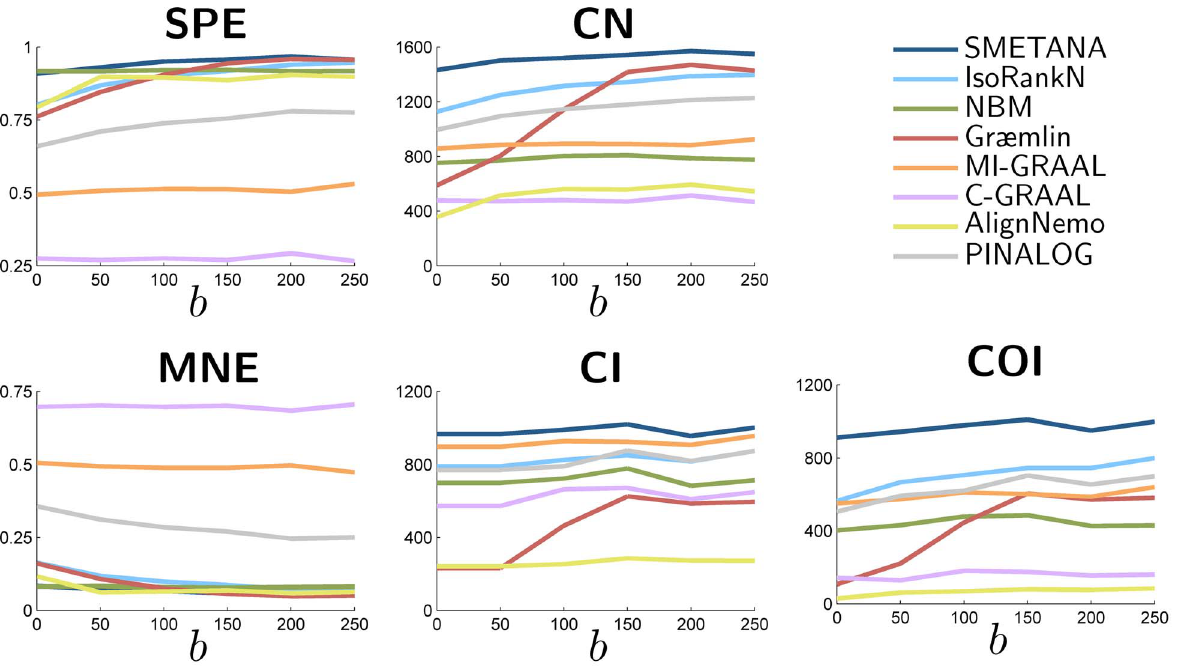
Figure 4. Effects of node similarity on the performance of different network alignment algorithms. The alignment performance has been estimated at several different levels of separation between the similarity score distribution for orthologous node pairs and that for non- orthologs pairs. Increasing the bias b increases the separation between the two score distributions, which increases the discriminative power of the node similarity score for predicting potential orthologs. Measures reported: specificity (SPE), number of correct nodes (CN) (which reflects the sensitivity), mean normalized entropy (MNE), number of conserved interactions (CI), number of conserved orthologous interactions (COI).